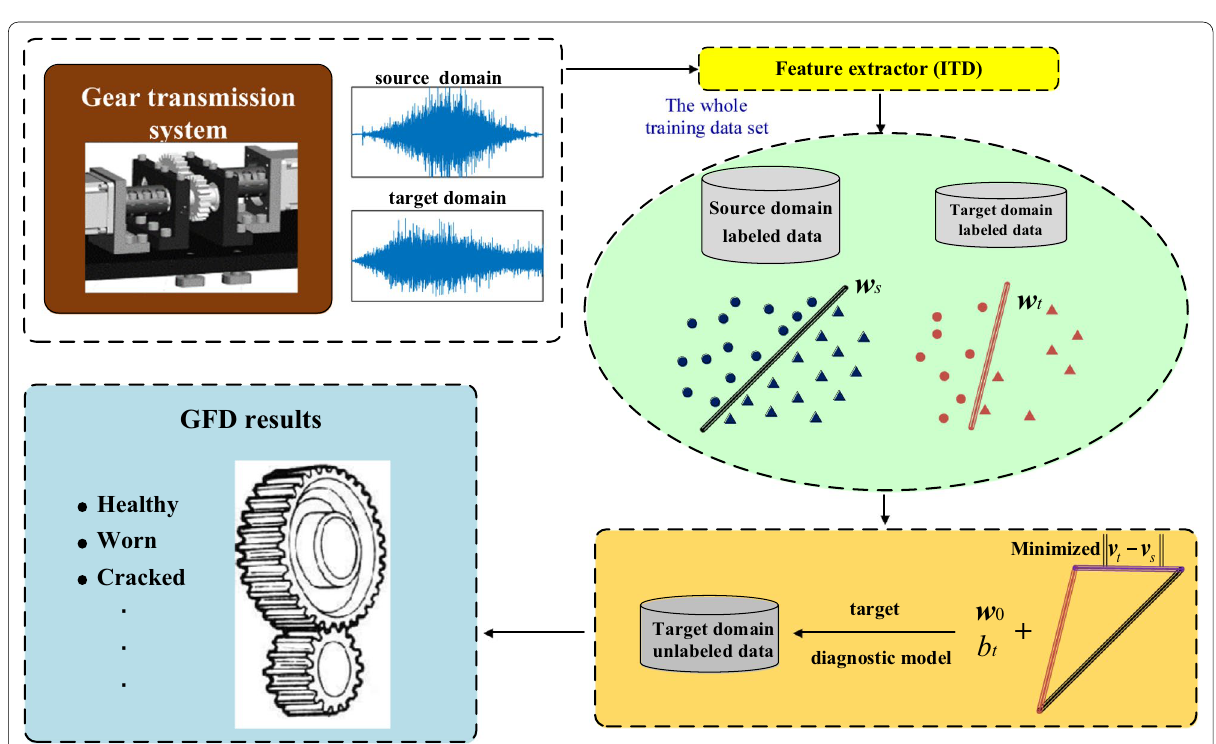
Figure 3 The whole framework of our method for